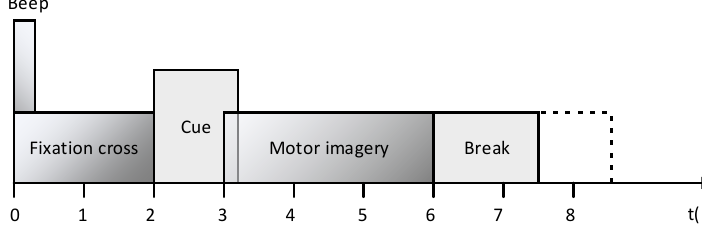
Figure 2. Timing scheme of a trial in BCI Competition IV 2a dataset.